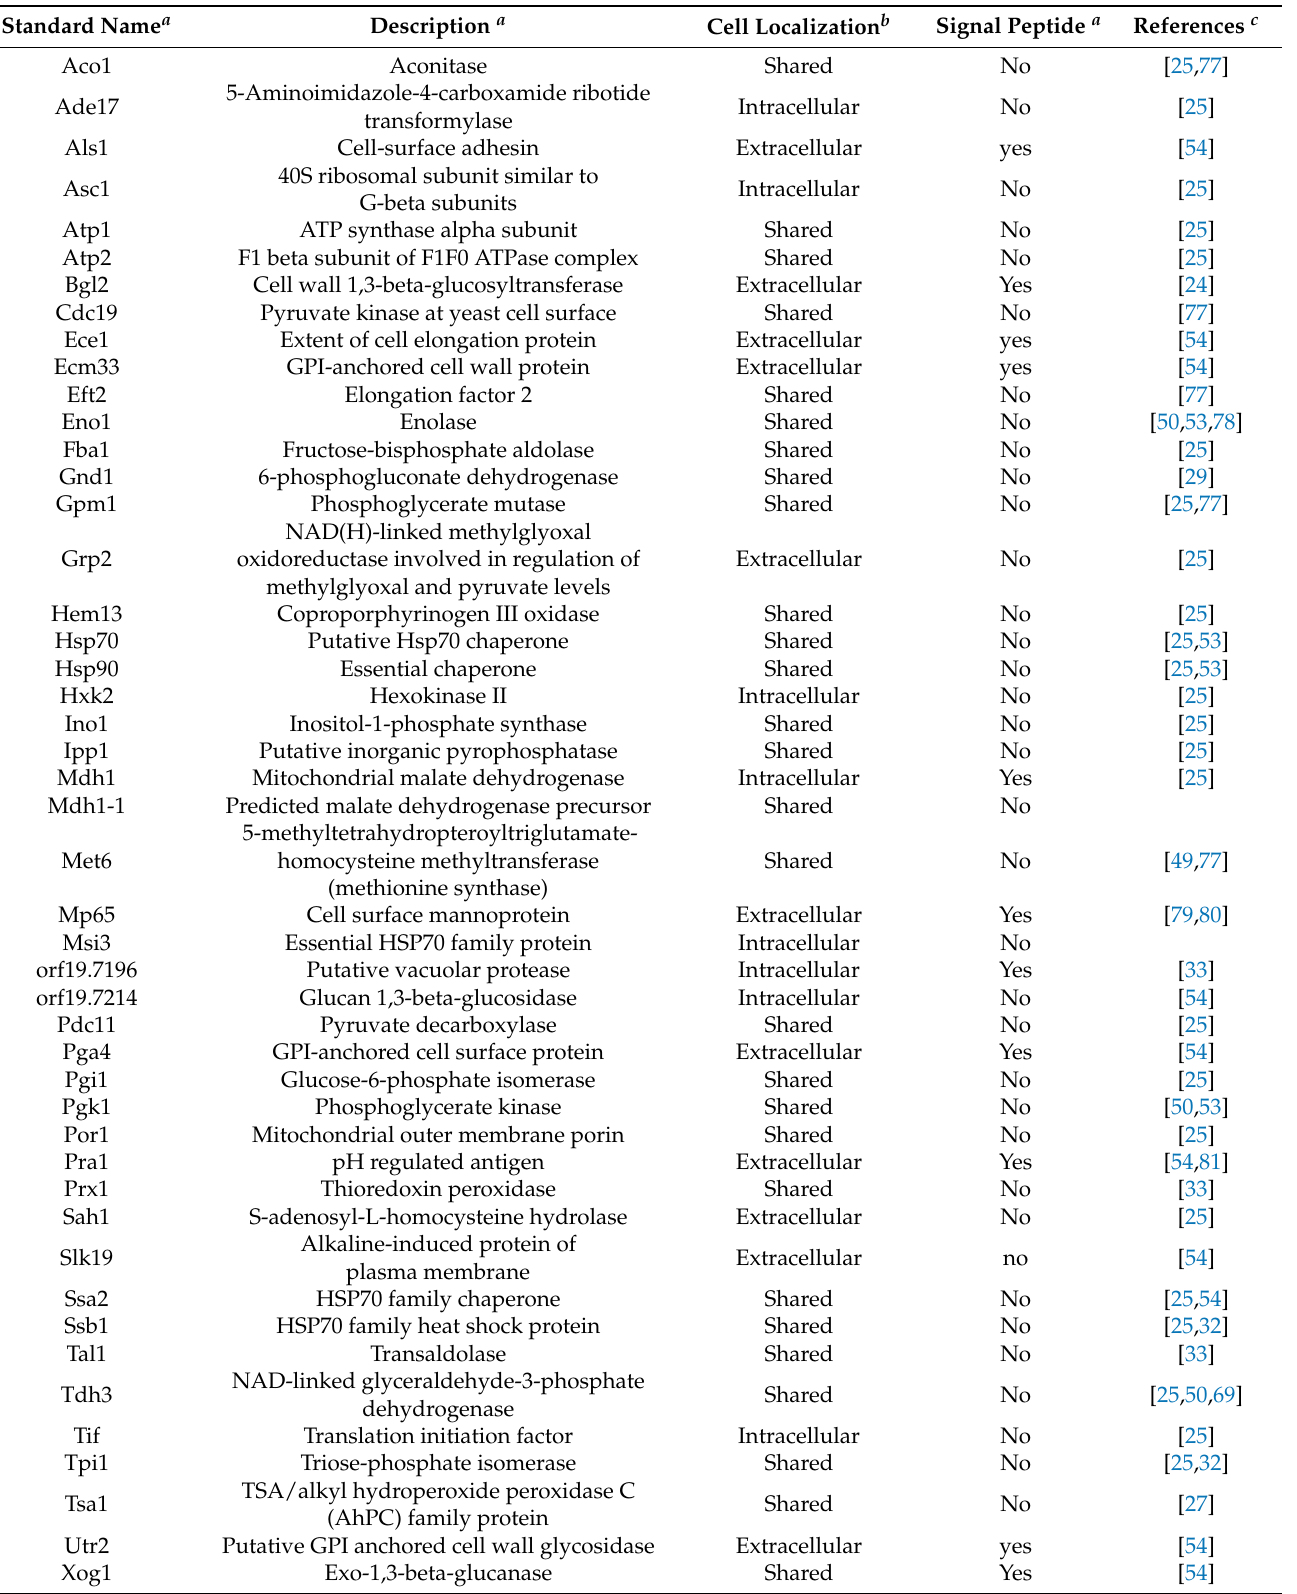
Table 4. LC-MS/MS-identified proteins that have shown to have immunogenic properties in previous